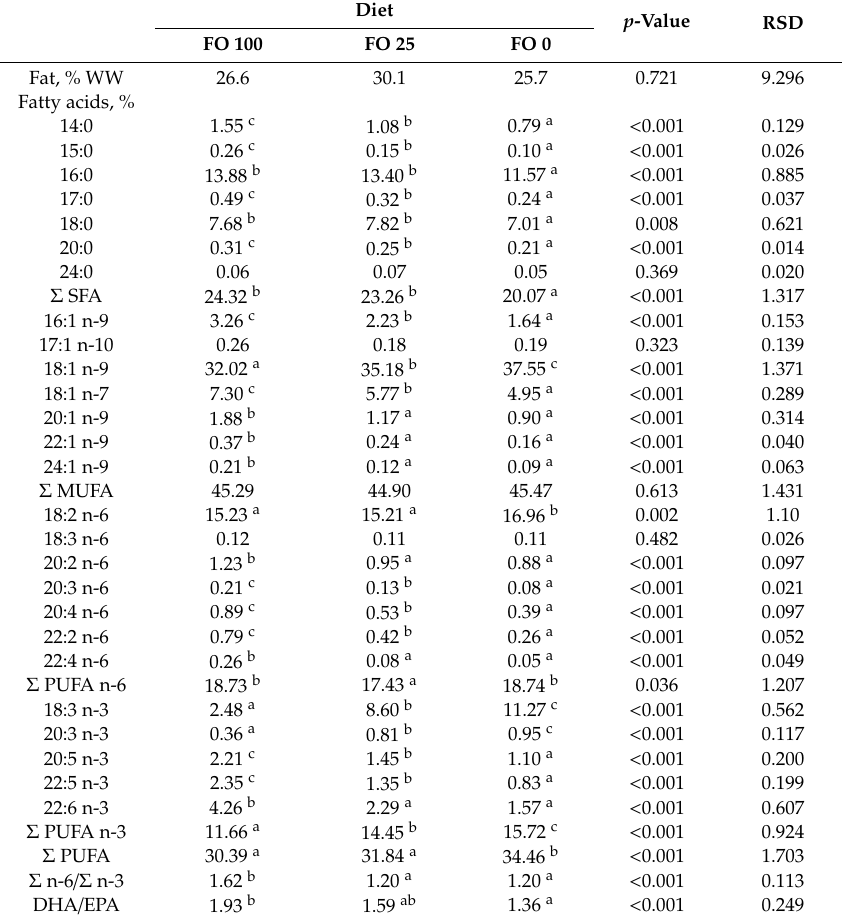
Table4. Fatcontentandfattyacidcomposition(%oftotalfattyacidcontent)oftheliverinMediterranean yellowtail fed the experimental diets ( n = 12 per diet). Values are expressed as LS